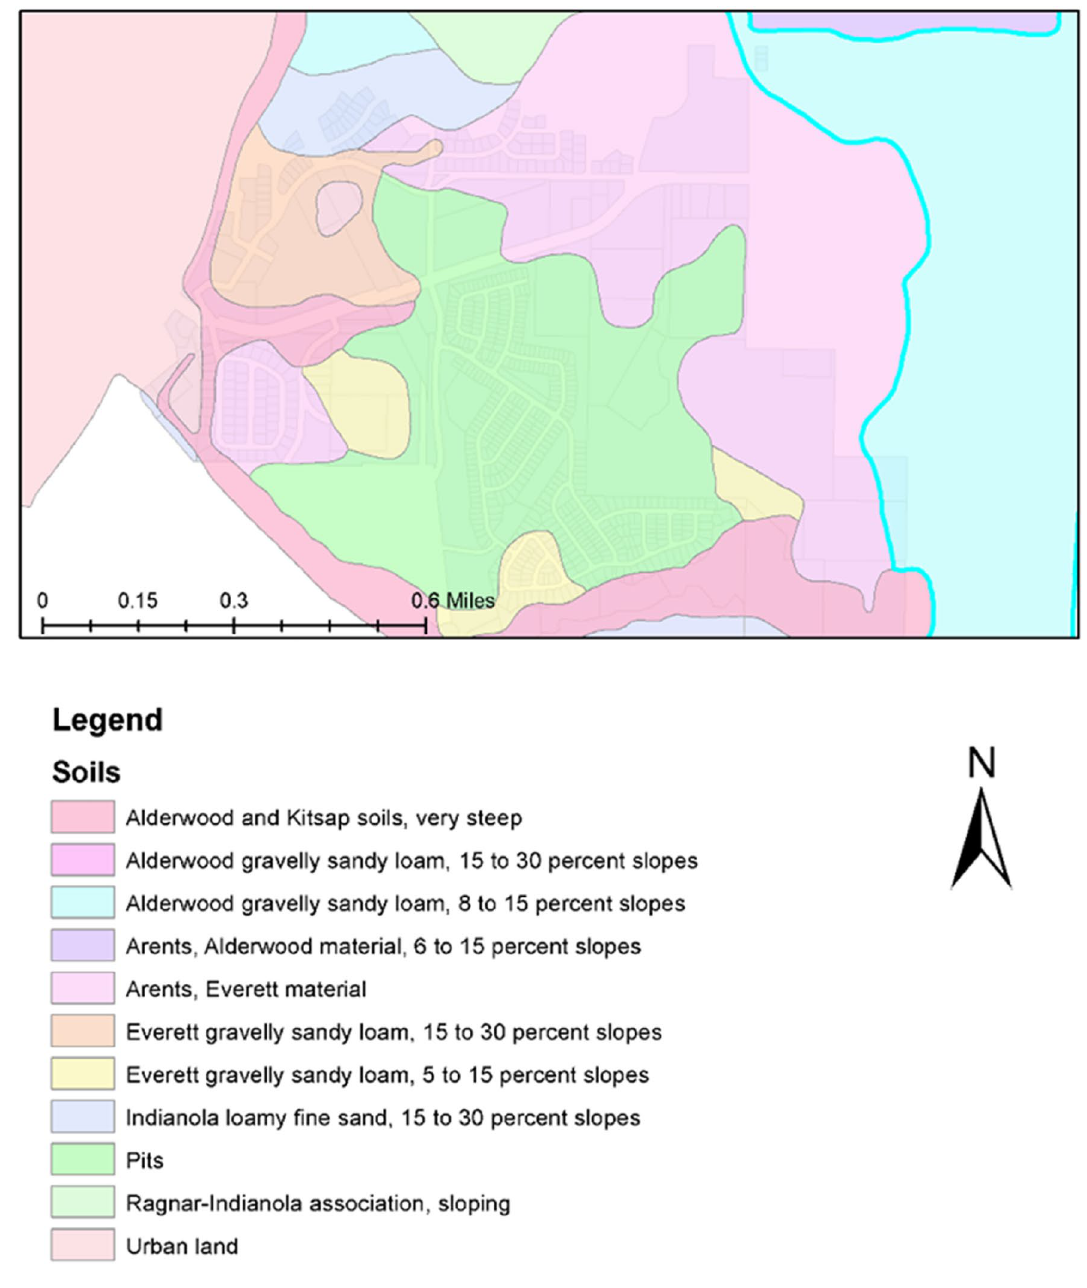
Figure 2. Distribution of different soil classes across the study area (Renton city